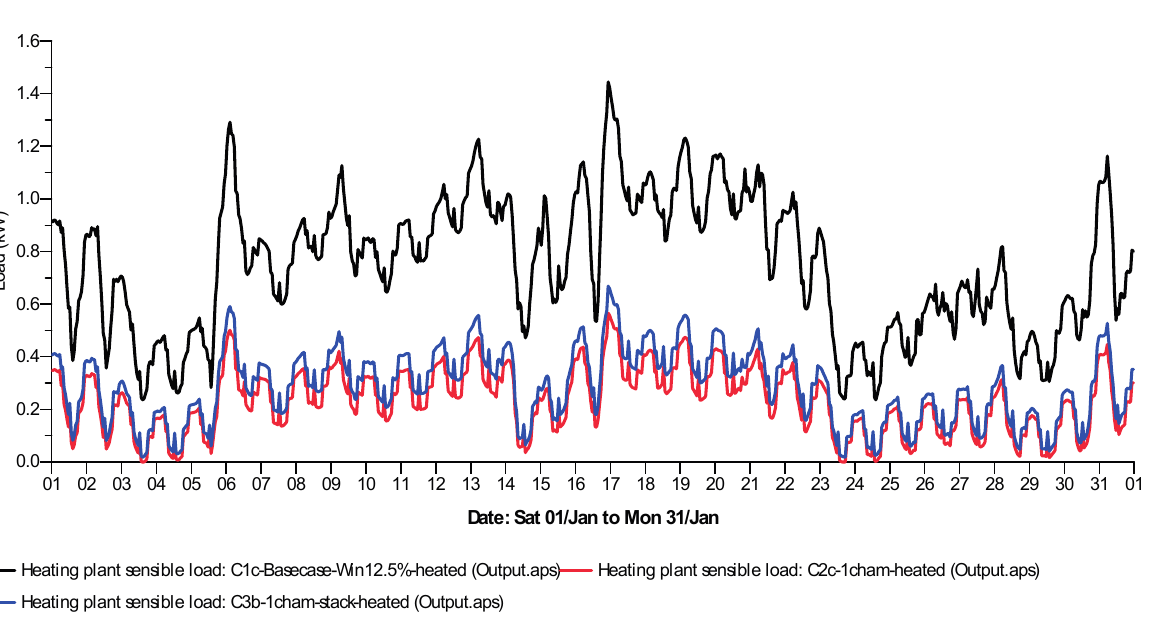
Figure 3. Power required for active space heating in Cases 1c, 2c and 3c.